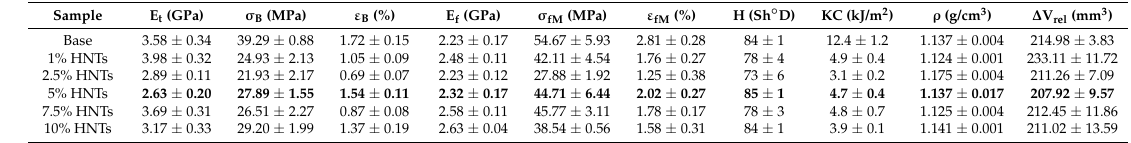
Table 1. Selected properties of base material and acrylic-based composites with variable HNTs content.